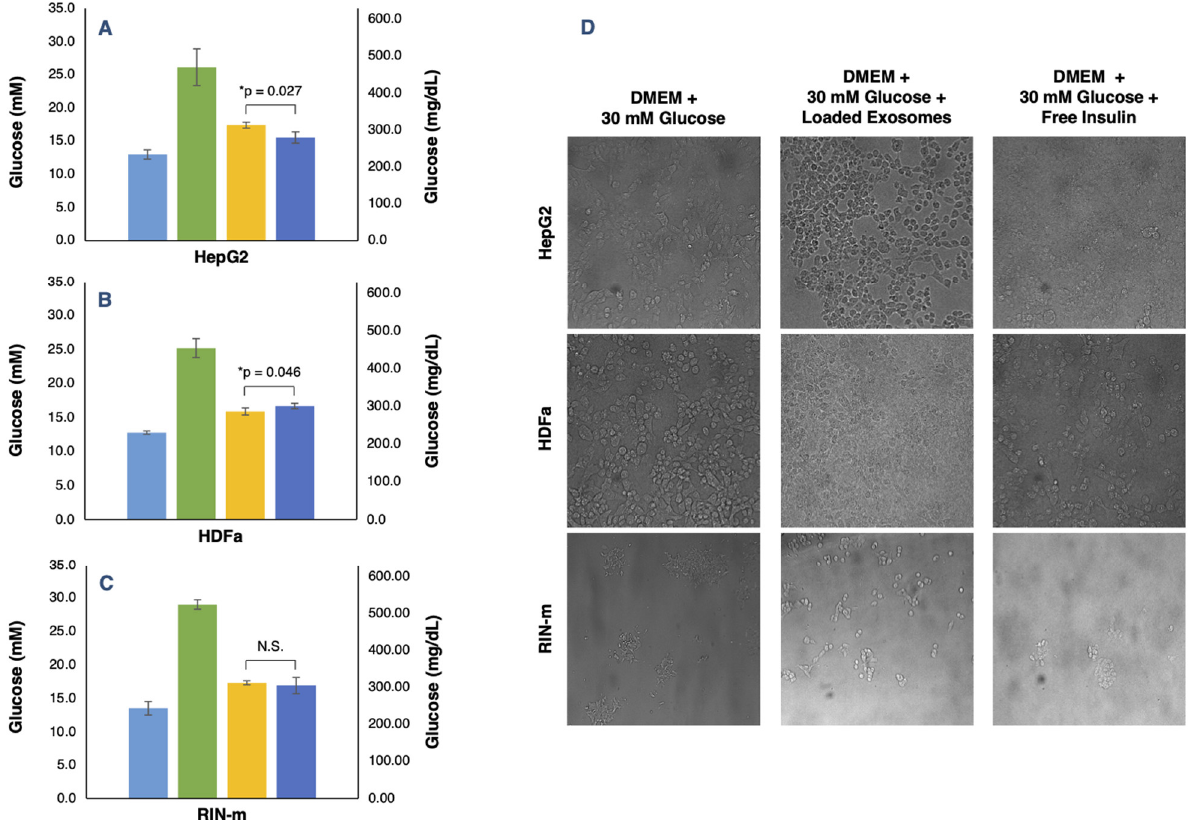
Figure 5. In vitro determination of glucose concentrations in HepG2, HDFa and RIN-m cell lines treated with DMEM + 10% FBS (light blue bars), DMEM + 30 mM glucose (green bars), DMEM + 30 mM glucose + insulin-loaded exosomes (yellow bars) and DMEM + 30 mM glucose + free insulin (dark blue bars). ( A ) HepG2-derived exosomes and free insulin treatments were significantly different ( p < 0.05), showing lower glucose levels in the DMEM + 30 mM glucose + free insulin treatment. ( B ) HDFa-derived exosomes and free insulin treatments presented significant differences ( p < 0.05), showing lower glucose levels in the DMEM + 30 mM glucose + insulin-loaded exosome treatment. ( C ) Loaded RIN-m derived exosomes and free insulin treatments did not present significant differences ( p < 0.05), showing equal glucose concentration levels. ( D ) Morphological and cell population variation for the DMEM + 30 mM glucose, DMEM + 30 mM glucose + insulin-loaded exosomes and DMEM + 30 mM glucose + free insulin treatments in the HepG2, HDFa and RIN-m cell lines. Brightfield images were captured 24 h after starting each treatment. The error bars in the graphs represent the mean concentration plus the standard error. * Significant differences between treatments (Student’s t -test; p < 0.05); N.S. represents non-significant differences.